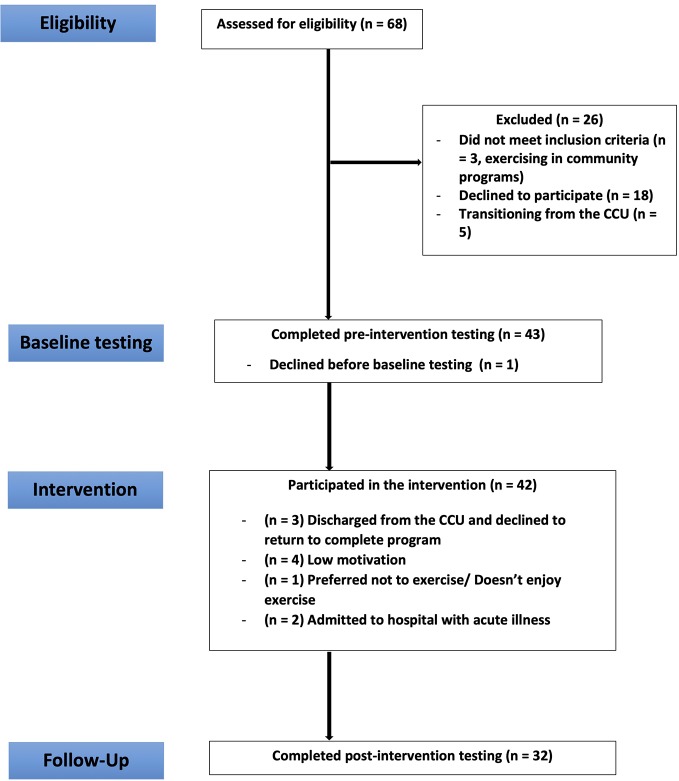
CONSORT diagram.